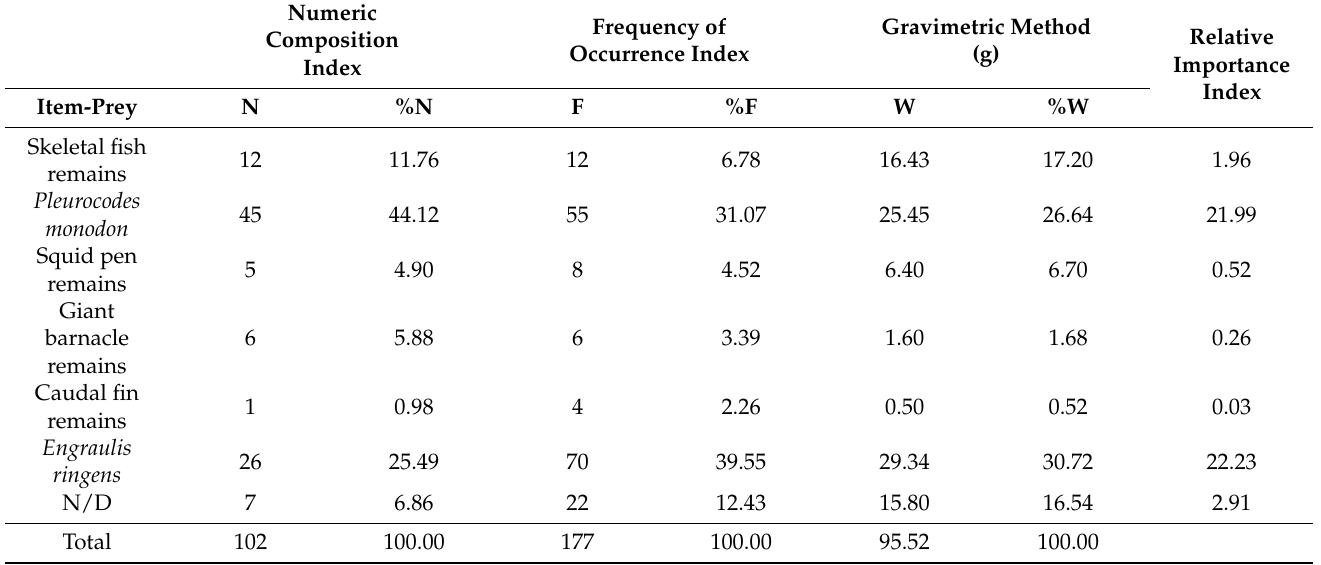
Table 4. Frequency of occurrence (%F), Numerical (%N), Gravimetric (%W) and Relative Importance Indexes (IIR) in stomach content for Sarda chiliensis chiliensis in the area of